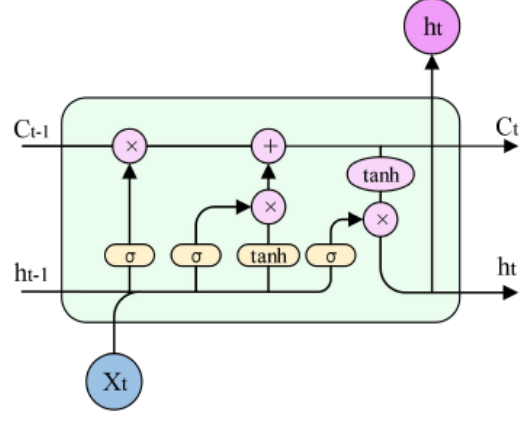
Figure 8. Schematic of LSTM unit.